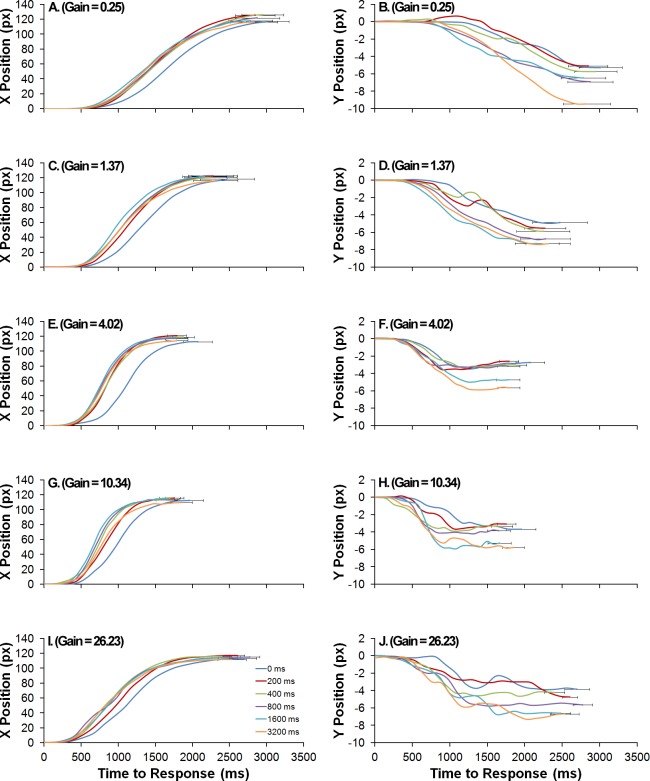
Mean horizontal (left column, panels A, C, E, G and I) and vertical (right column, panels B, D, F, H and J) positions of the cursor as a function of response time (abscissas) for the different gain conditions (rows) and retention intervals (line parameter). Horizontal error bars depict the standard error of the mean response times.